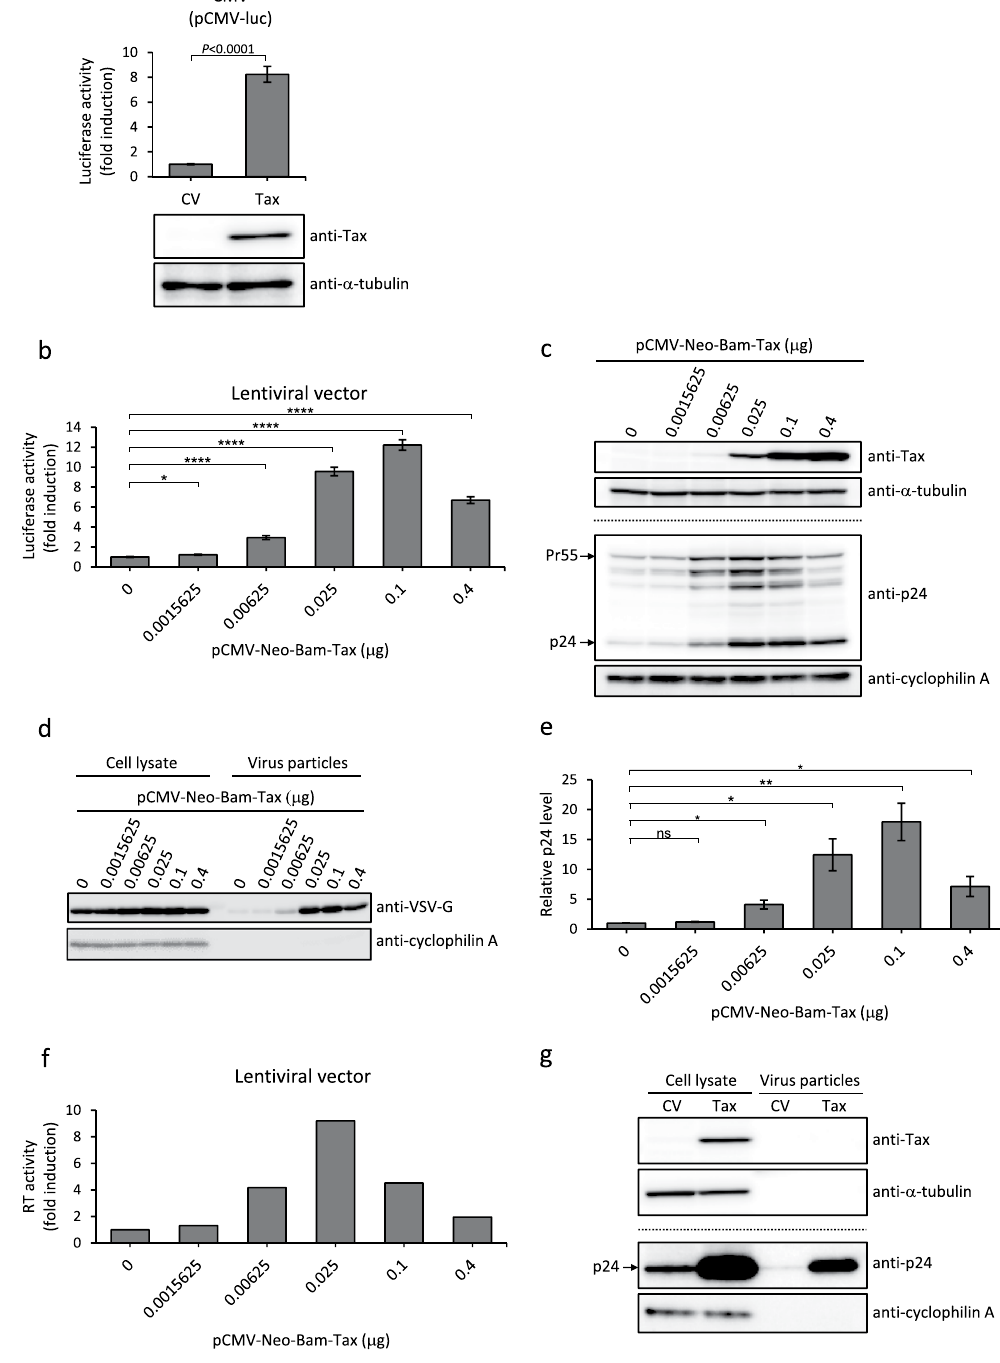
Figure 3. HTLV-1 Tax robustly enhances lentiviral vector production. ( a ) Approximately 2 × 10 5 HEK293T cells were co-transfected with 0.1 μ g of pCMV-luc and 0.2 μ g of pCMV-Neo-Bam-Tax (Tax) or pCMV-Neo- Bam as control vector (CV). The luciferase activity was normalized against the protein concentration and the results are shown as fold-increase compared to the CV (upper panel). Cell lysates were subjected to western blotting with the indicated antibodies. ( b ) Approximately 1.5 × 10 6 HEK293T cells were co-transfected with either CV or increasing amounts of pCMV-Neo-Bam-Tax. The total amount of the effector plasmids was adjusted to 0.4 μ g. Lentiviral vector-containing culture supernatants were harvested 48 hours post-transfection. Transduction efficiency in MT-4 cells exposed to the culture supernatant was evaluated. The luciferase activity was normalized against the protein concentration. ( c ) Transfected cells shown in Fig. 3b were harvested. The same set of 30 μ g of lysates was subjected to western blotting using two membranes; one was probed with anti- Tax antibody and then reprobed with anti- α -tubulin antibody; the other was probed with anti-HIV-1